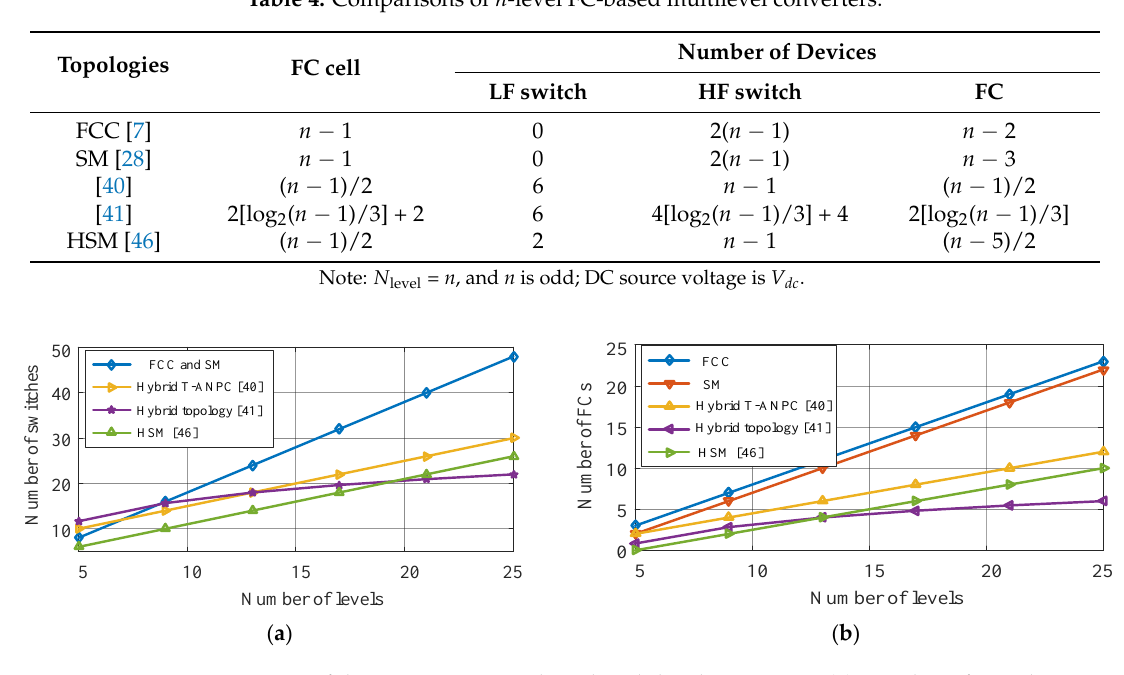
Table 4. Comparisons of n -level FC-based multilevel converters.